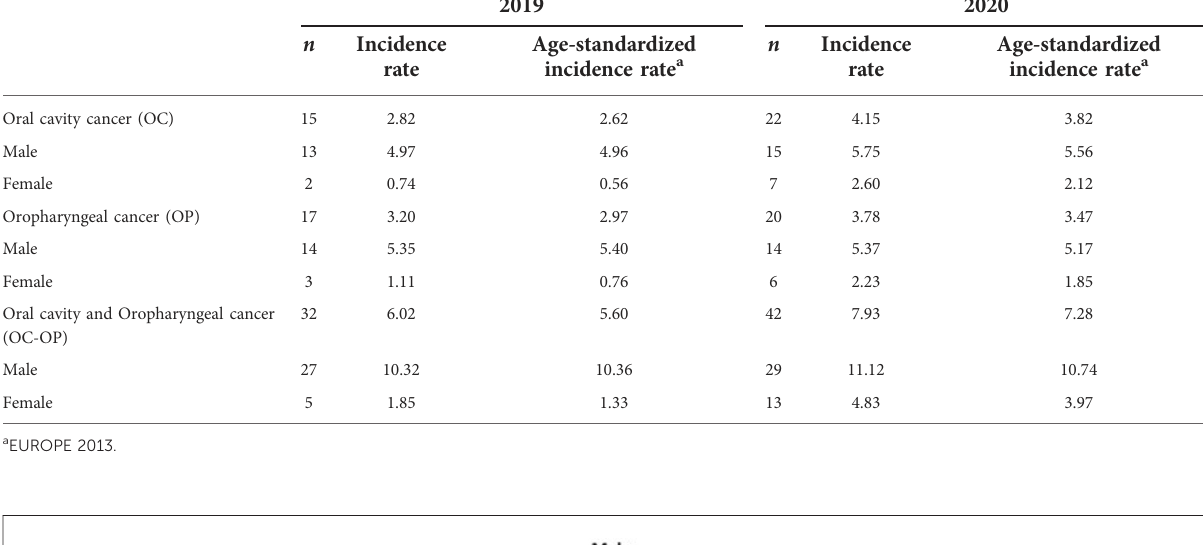
TABLE 2 Age-standardized incidence rate by subtype and sex. 2020 vs.